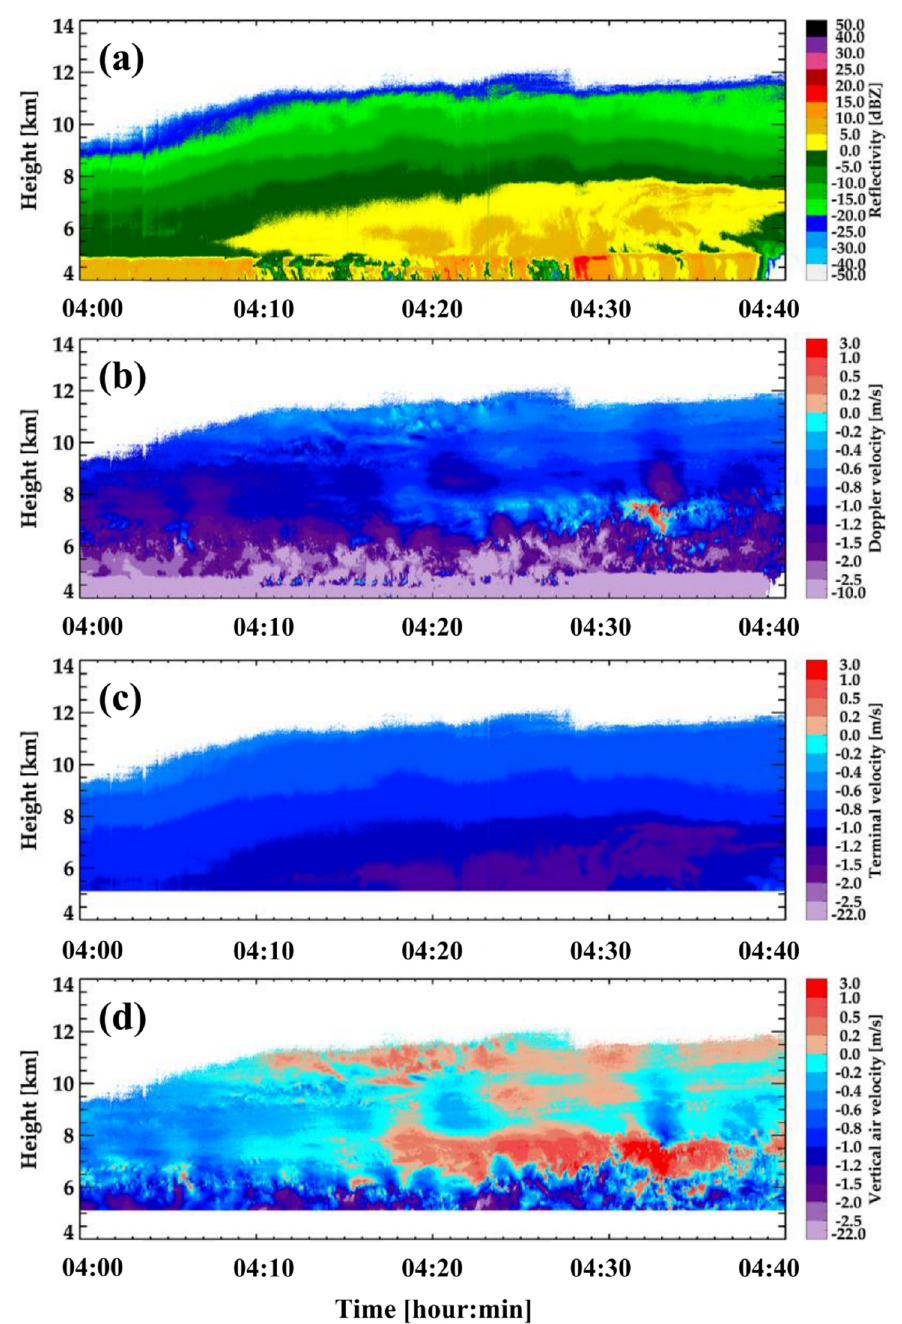
Figure 16. Time–height cross-sections of ( a ) observed Z , ( b ) observed V D , ( c ) V t retrieved from V t – Z relationship, and ( d ) retrieved V air for a case at 04 UTC on 18 June 2013. The three major layers of upward motion were observed at around 10.5, 9, and 7